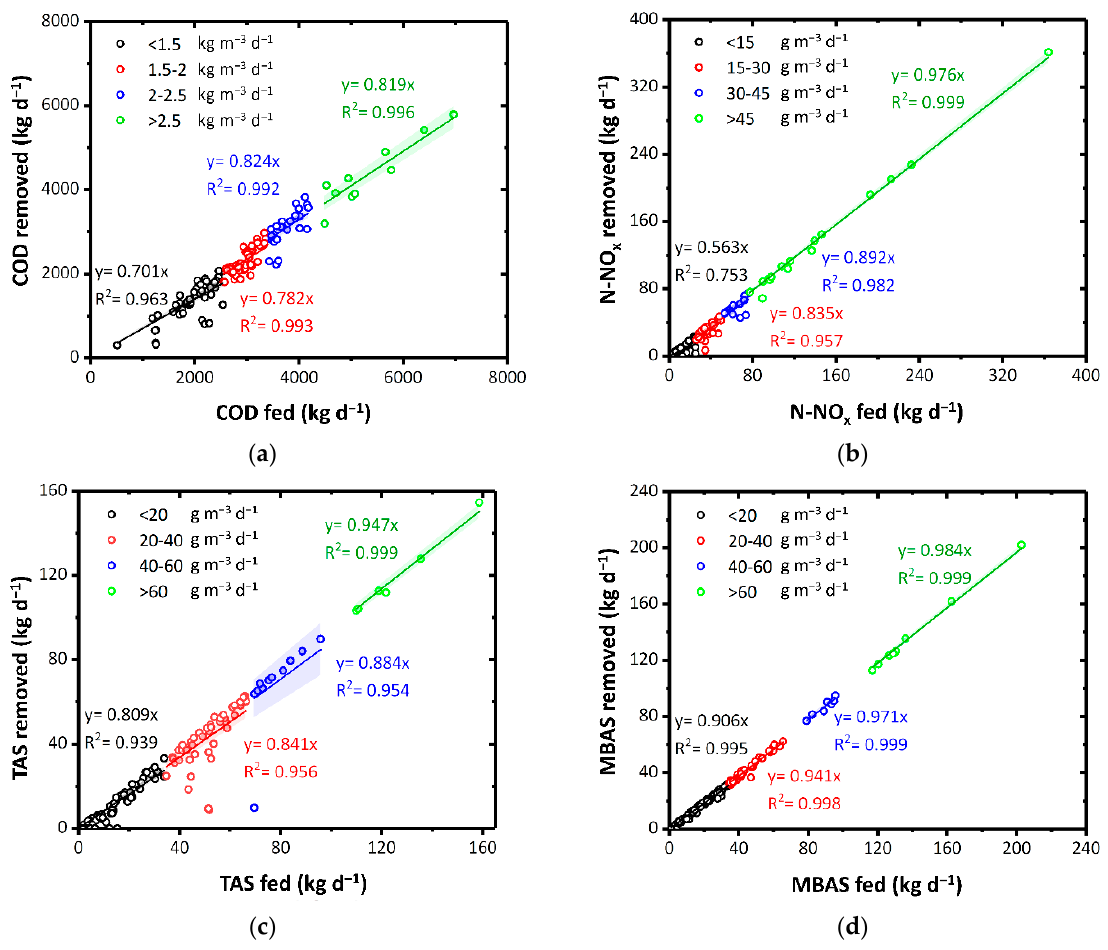
Figure 2. ( a ) COD, ( b ) N-NO x ( c ) TAS, and ( d ) MBAS removal as a function of pollutants fed. Colors highlight diverse load rates. The colored bands represent the 95% confidence interval of the linear fitting.